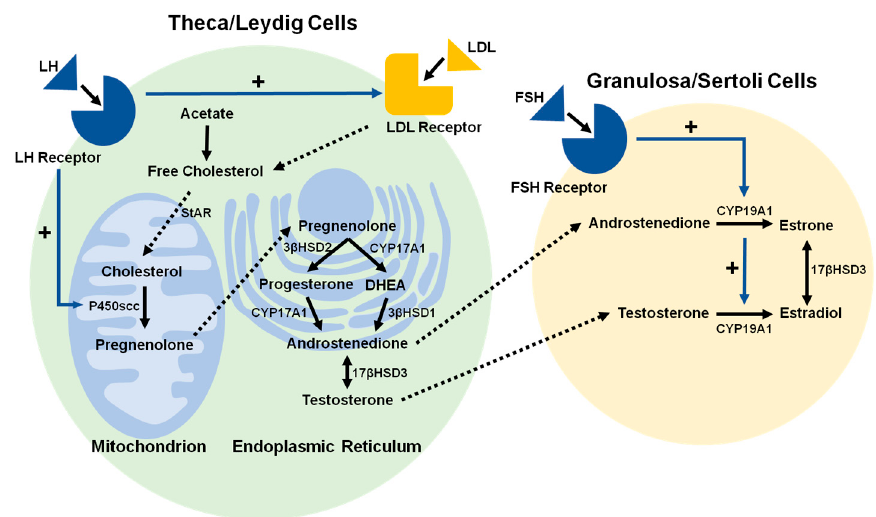
Figure 1. Schematic illustration of the process by which cholesterol is converted to steroid hormones in theca and granulosa cells in females and in Leydig and Sertoli cells in males. Free cholesterol is deposited into theca and Leydig cells by low-density lipoprotein (LDL) receptor-mediated LDL endocytosis. The conversion of cholesterol to pregnenolone is initiated by the binding of luteinizing hormone (LH) to the luteinizing hormone receptor (LHR), and conversion of androgens to estradiol (E 2 ) is initiated by the binding of follicle-stimulating hormone (FSH) to the follicle-stimulating hormone receptor (FSHR). While the steroidogenic pathways in female and male reproductive organs are nearly identical, the principal hormone products of steroidogenesis differ in females and males, as indicated in the text. (Black solid line arrows: synthesis step; blue solid line arrow with + symbol: activation; dotted line arrows: transfer step).